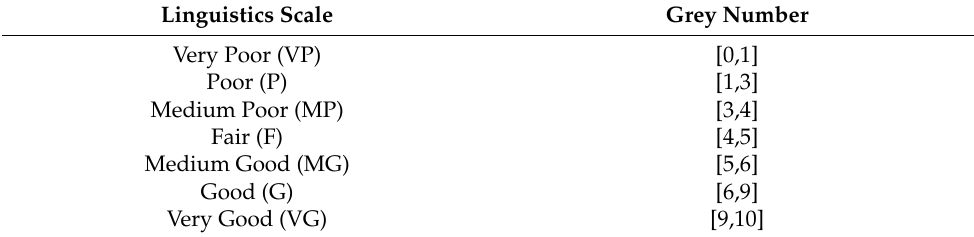
Table 2. The linguistics scale with grey numbers of the G-TOPSIS model. Linguistics Scale Grey